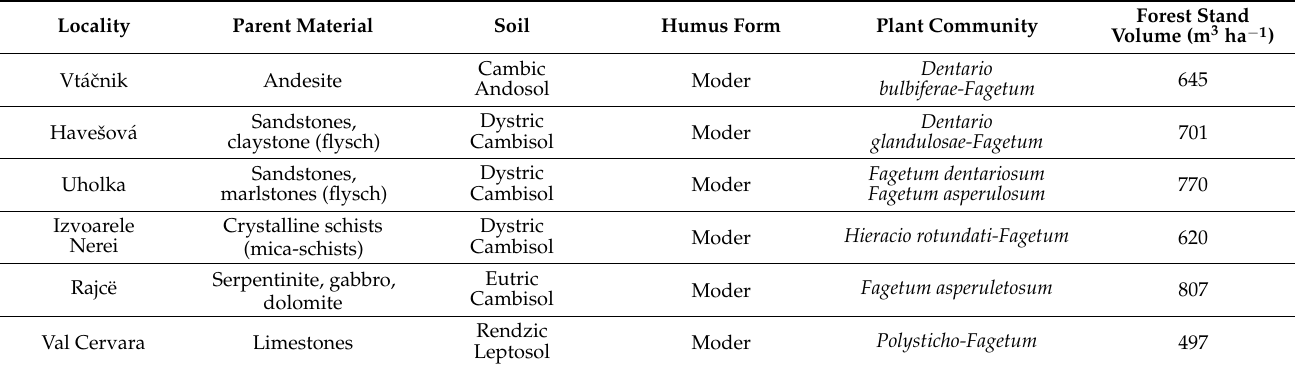
Table 2. Geological, soil, and vegetation characteristics of the research localities. Data were collected from [46–52]. Soils are presented according to